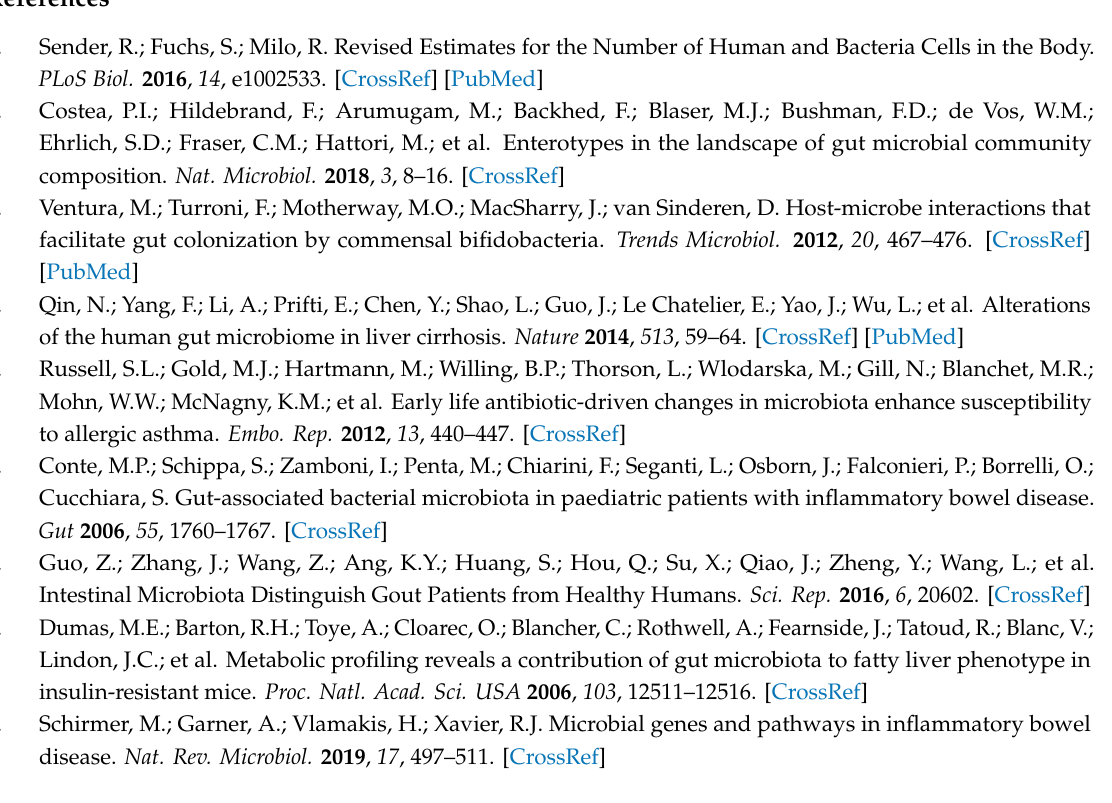
Figure S1: Principal coordinates analysis (PCoA) of weighted UniFrac distances based on the high-throughput sequencing data of the V4 region of the 16S rRNA gene.; Figure S2: Alpha-diversities of the bifidobacterial communities within subjects from di ff erent regions and across age groups. Boxes show the interquartile range (IQR) between the first and third quartiles, and the lines inside boxes represent the median. Whiskers denote the lowest and highest values within 1.5 × IQR from the first and third quartiles, respectively. The points present the values with distance from the median exceeding 1.5 times IQR.; Figure S3: Figure. S3 Principal coordinates analysis (PCoA) of weighted UniFrac distances based on high-throughput sequencing of the groEL gene.; Figure S4: Composition of the bifidobacterial community within subjects from di ff erent regions (a) and across di ff erent ages (b).; Table S1: Basic information of experimental subjects.; Table S2: p -value of PERMANOVA test between each region-group., Table S3: p -value of PERMANOVA test between each